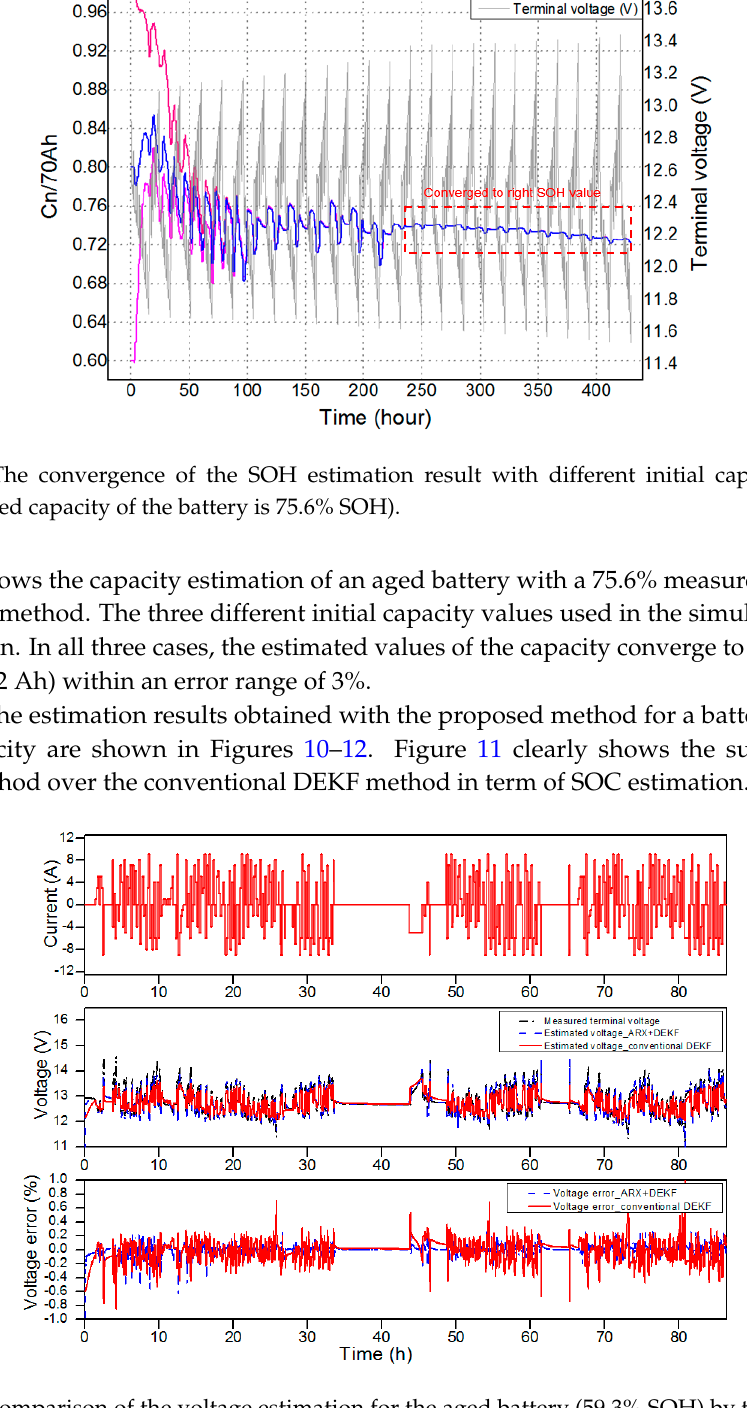
Figure 10. Comparison of the voltage estimation for the aged battery (59.3% SOH) by the proposed ARX-DEKF and conventional DEKF method.